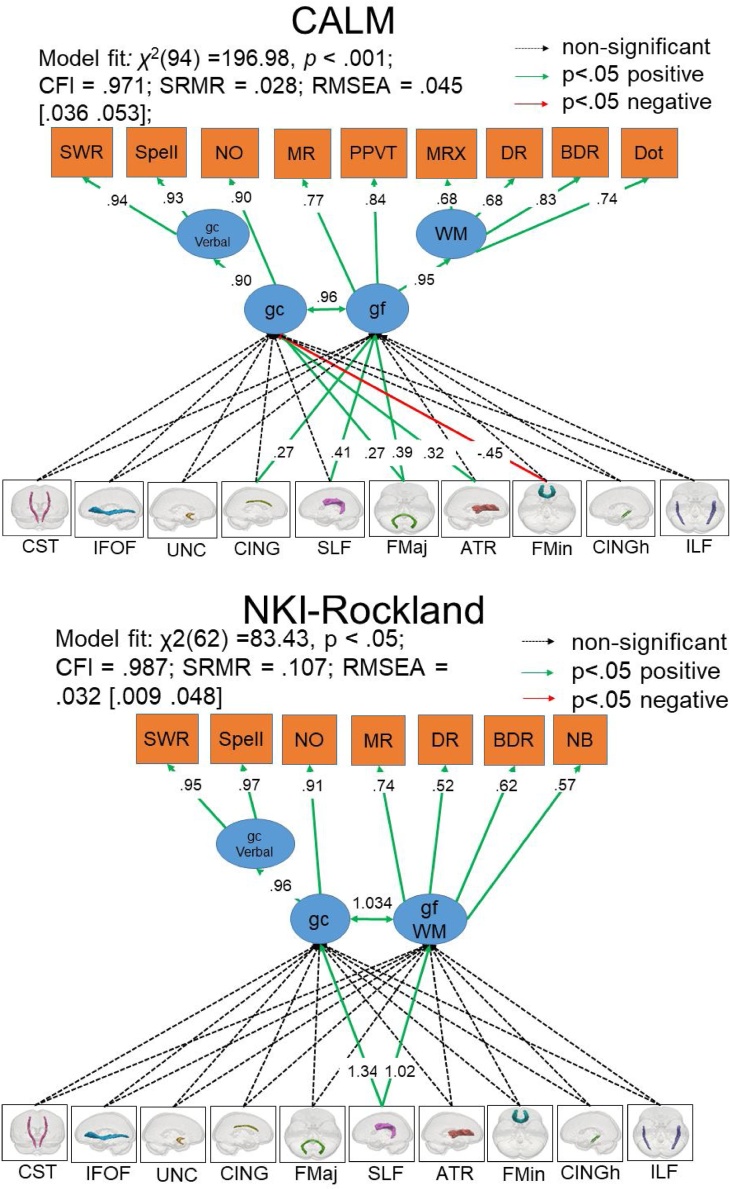
MIMIC models displaying standardized parameter estimates and regression coefficients for all cognitive measures and white matter tracts for complete CALM and NKI-Rockland samples. Dotted, green, and red arrows indicate nonsignificant (>.05), positively significant, and negatively significant path estimates, respectively. Note standardized estimates exceeding 1 in NKI are likely the consequence of highly-correlated factors (Jöreskog, 1999).